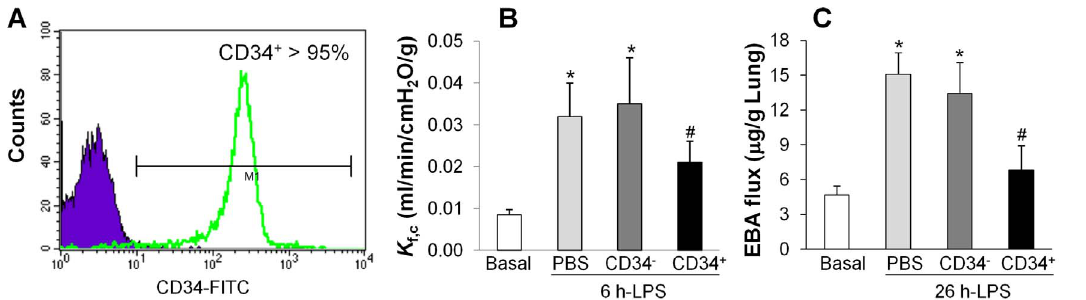
Figure 1. Inhibition of lung vascular permeability in mice treated with fCB-CD34 + cells. ( A ) FACS analysis demonstrating greater than 95% purity of CD34 + cells. Low density human cord blood cells ( , 1.077 g/ml) were obtained by density centrifugation on Ficoll-Paque PLUS, from which CD34 + cells were isolated by the MACS CD34 progenitor isolation kit using immunomagnetic beads. Purple histogram indicates matched isotype control and staining with CD34 monoclonal antibody is shown as green overlaid histogram. The purity of isolated CD34 + cells routinely ranged 90– 99%. ( B ) Decreased lung vascular permeability to liquid in mice treated with fCB-CD34 + cells. At 3 h post-LPS challenge (5 mg/kg, i.p.), cells or PBS were administered and